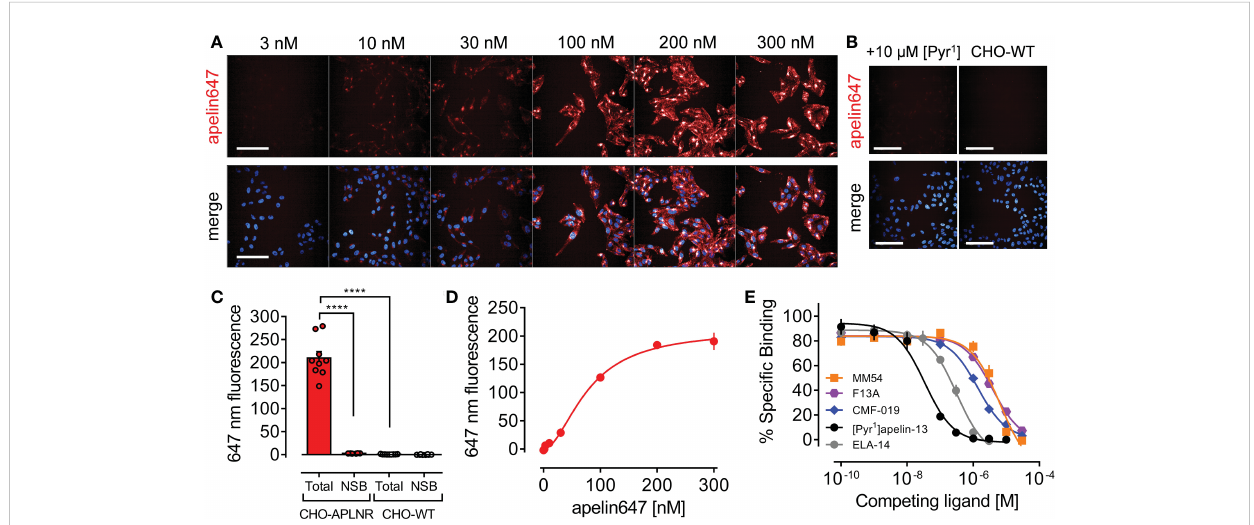
FIGURE 3 Validation of apelin647 as a robust tool for qualitatively and quantitatively assessing apelin receptor pharmacology using high content imaging. (A) Representative confocal fl uorescent images of CHO-APLNR cells treated with a concentration range up to 300 nM of apelin647 (visualised